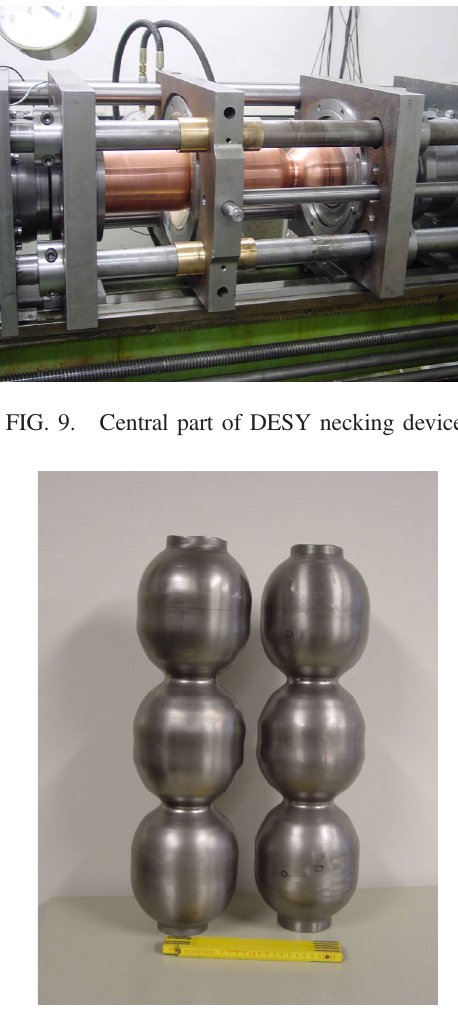
FIG. 10. Example of the Nb three-cell units after